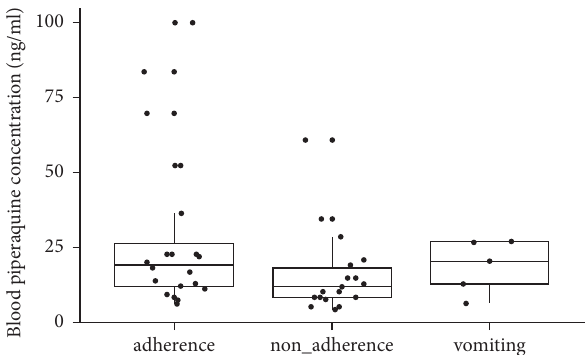
Figure 1: Box plots of blood piperaquine concentrations by ad- herence types (adherence, nonadherence, and vomiting). Hori- zontal line in the boxes represents median, while lower and upper error bars represent the first and the third